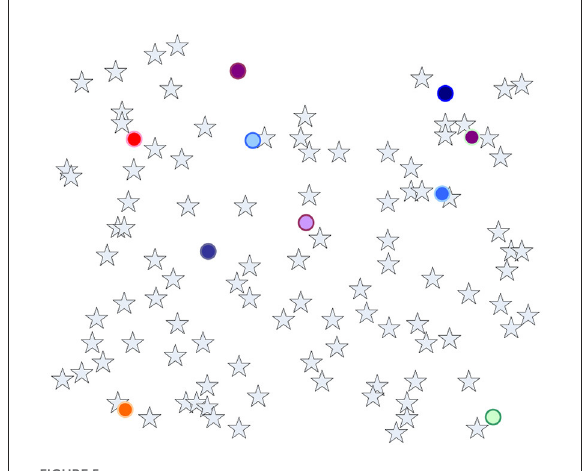
FIGURE7 Change process of cluster